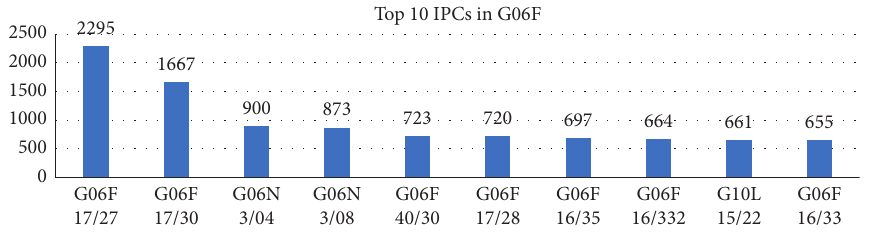
Figure 4: Top 10 IPCs in G06F.